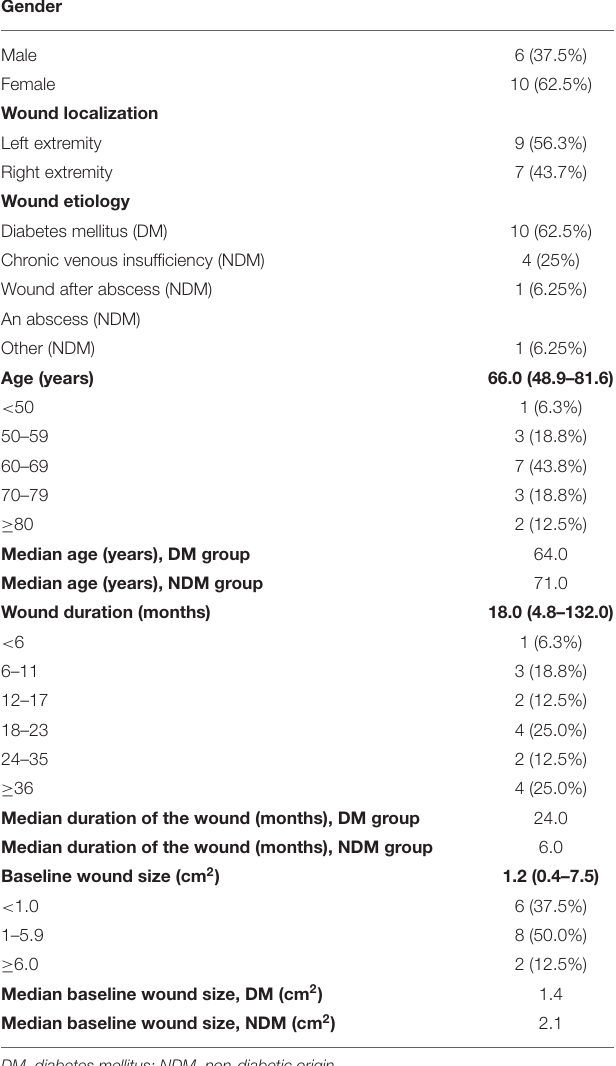
TABLE 3 | Patients